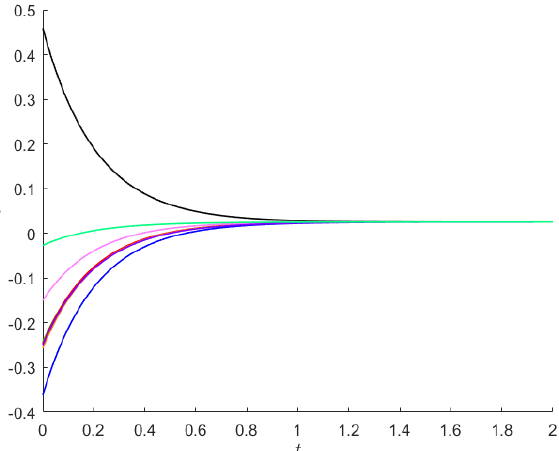
Figure 4. For Example 2, from 8 initial values (each shown using a separate color), are depicted the trajectories of state χ 2